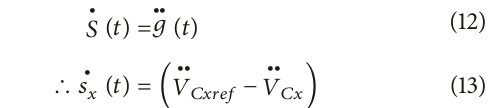
Figure 4: Block diagram of FSMC of series converter.